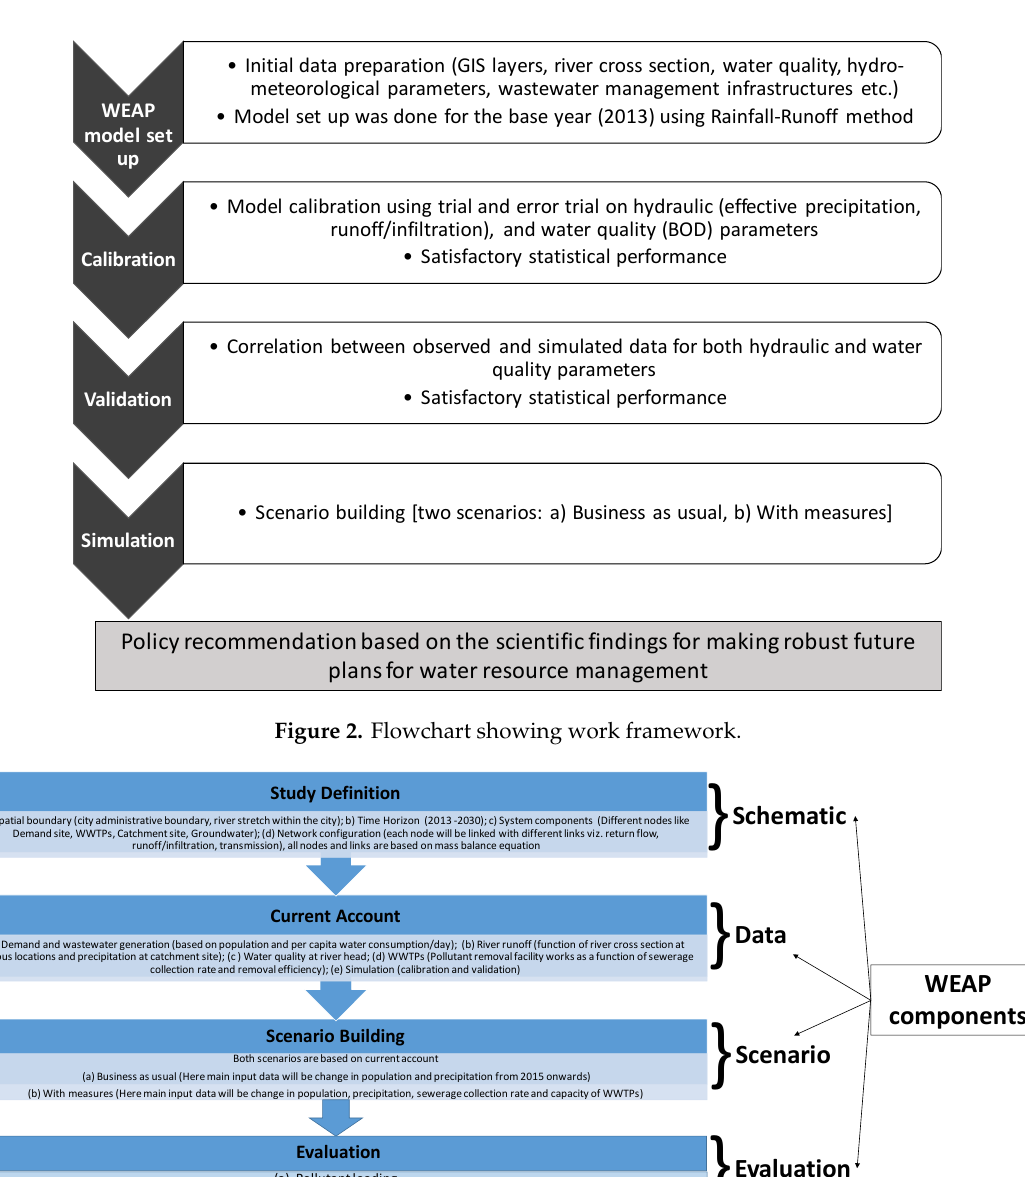
Figure 1. Study area map showing Adyar River passing across the south-central part of Chennai City.